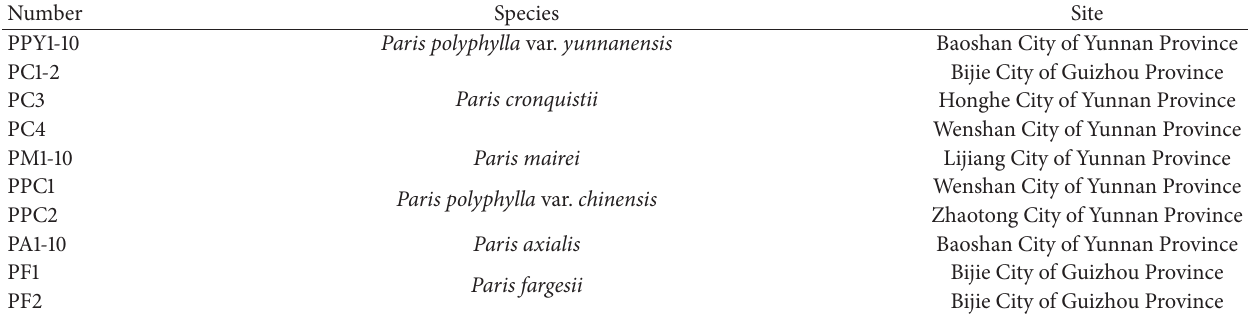
Table 1: Information of different species from different